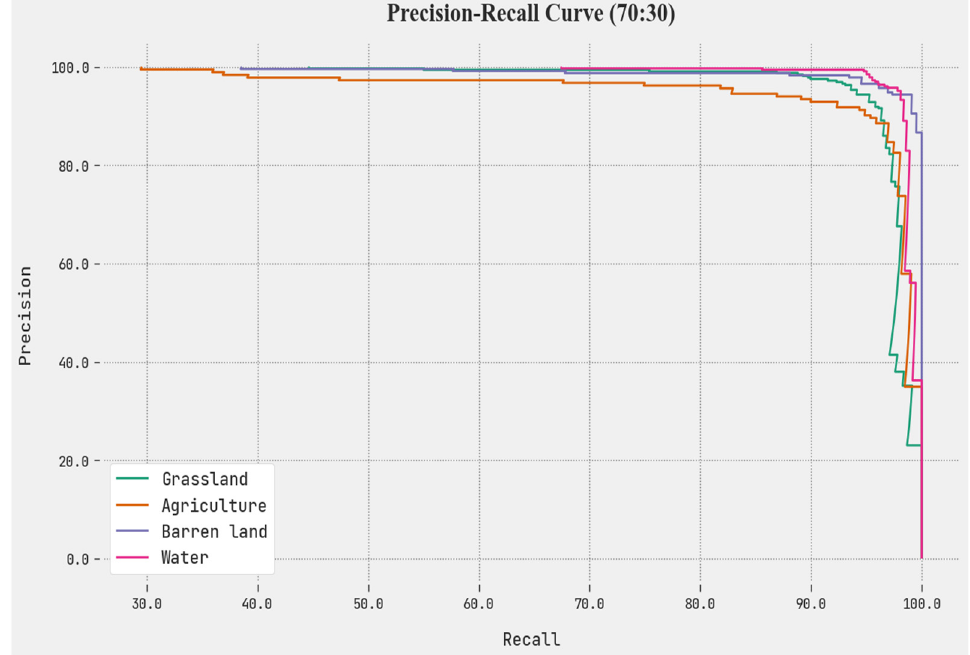
Figure 13. Precision-recall analysis of TSADL-LULCCD approach on 70:30 of TR/TS.